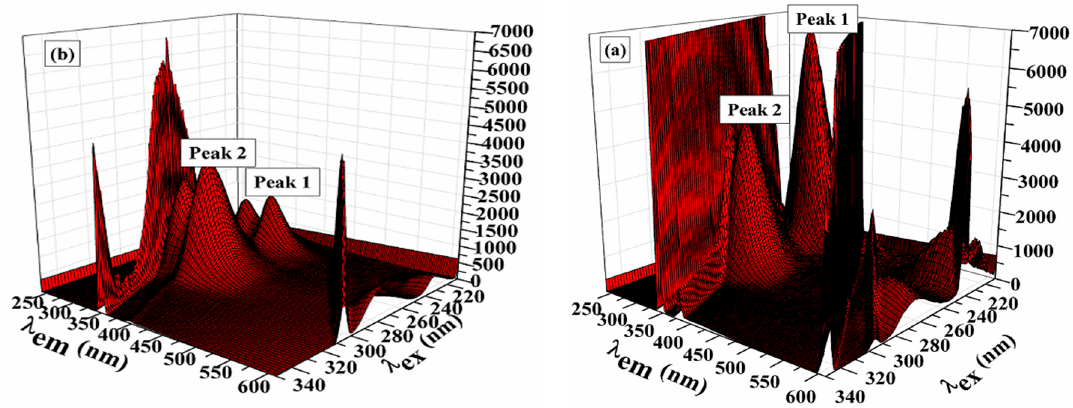
Figure 9. 3D spectra of BSA (1.5 µ M) in ( a ) absence and ( b ) presence of compound 3 (12.0 µ M).